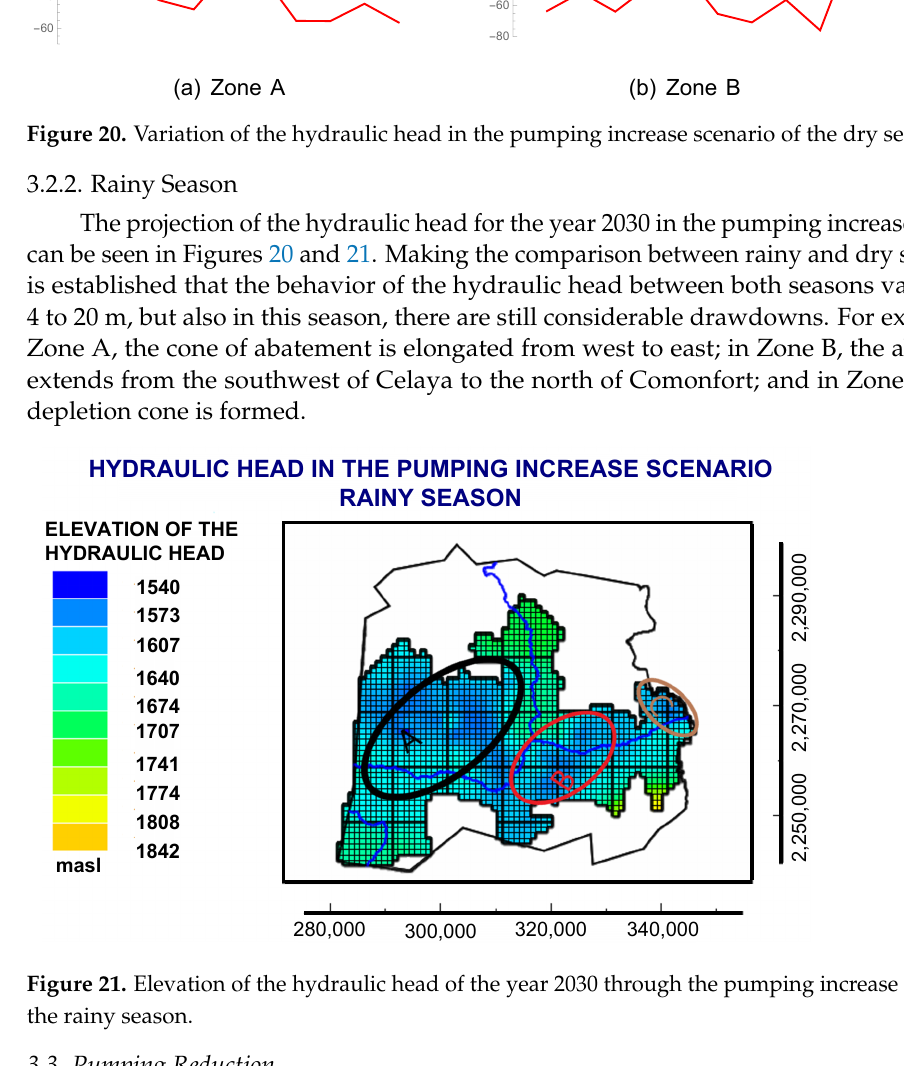
Figura 3.10: Isol´ıneas de la carga hidr´aulica del a˜no 2030 a trav´es del escenario Aumento de Bombeo en la Temporada de Lluvias.